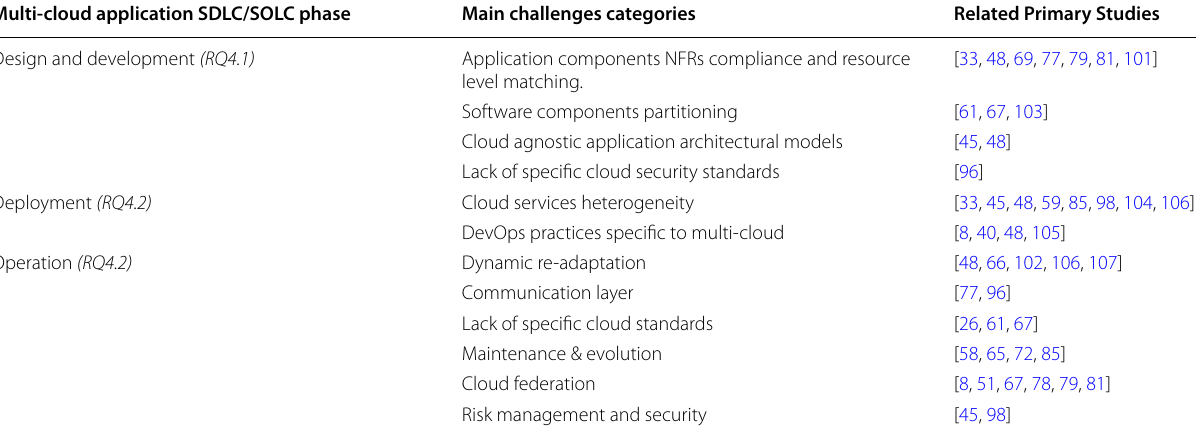
Table 8 Identified challenges in the SDLC/SOLC of multi‑cloud applications Multi‑cloud application SDLC/SOLC phase Design and development